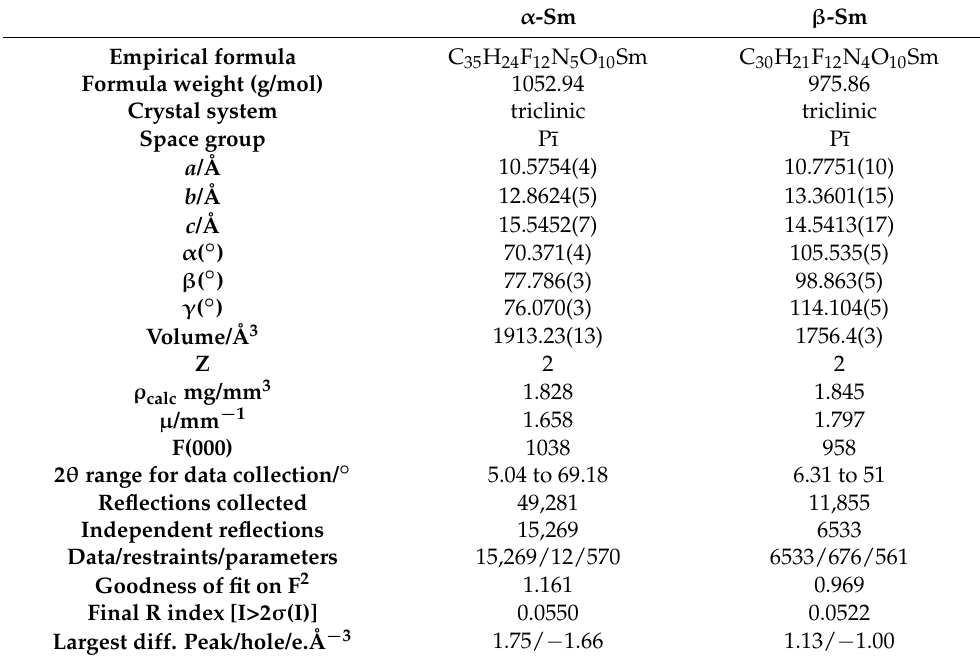
Figure 7. ORTEP-type diagrams with 50% of ellipsoid probability of the compounds ( a ) α-Sm and ( b ) β-Sm . ( b ) β -Sm . Table 1. Crystallographic data and refinement parameters for α-Sm and β-Sm compounds. Table 1. Crystallographic data and refinement parameters for α -Sm and β -Sm